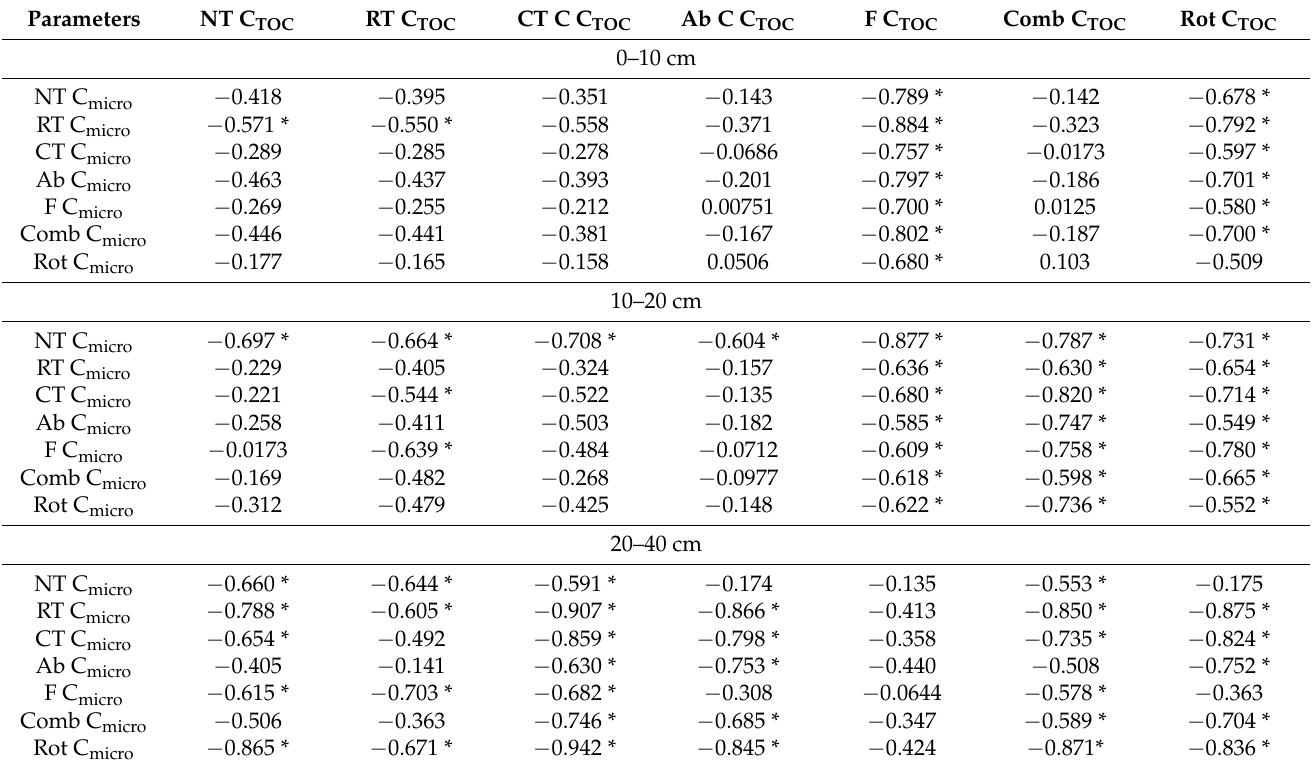
Table 1. K. Pearson’s linear correlation coefficients between C micro and C org